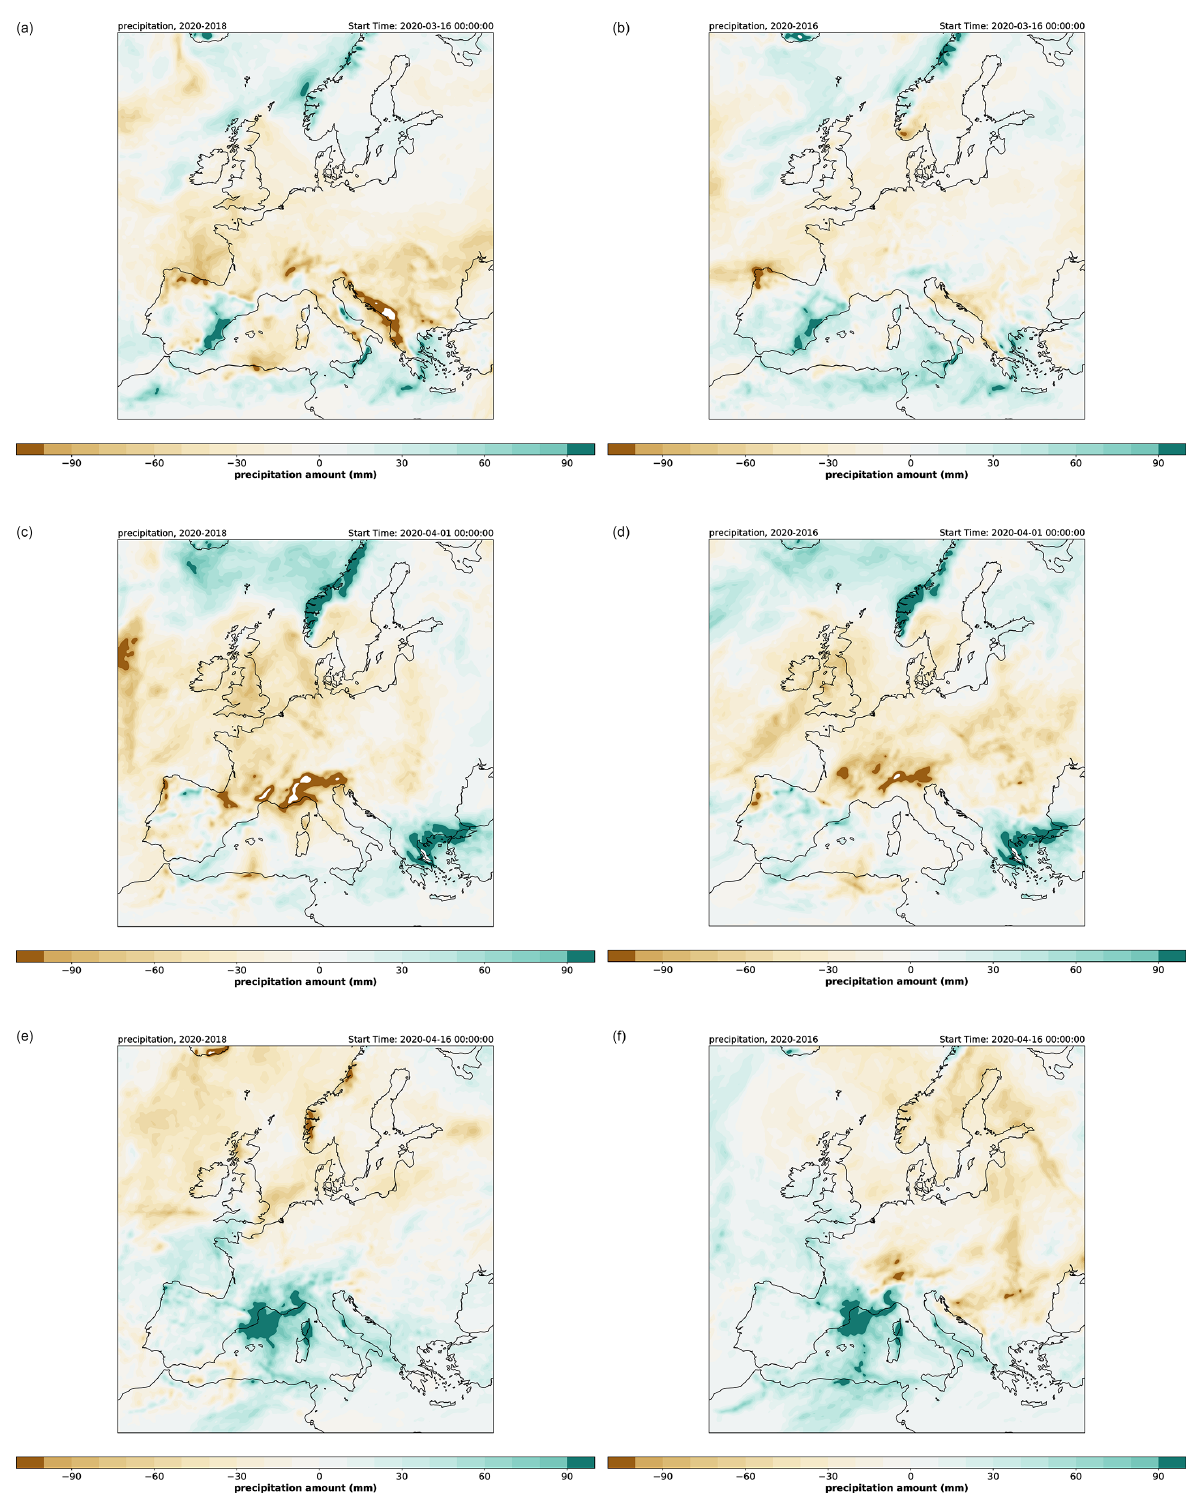
Figure A15. Accumulated precipitation (in mm, colour code): differences between 2020 and 2018 (a, c, e) and between 2020 and 2016 (b, d, f) for the half-month periods 16–31 March (a, b) , 1–15 April (c, d) and 16–30 April (e, f) .